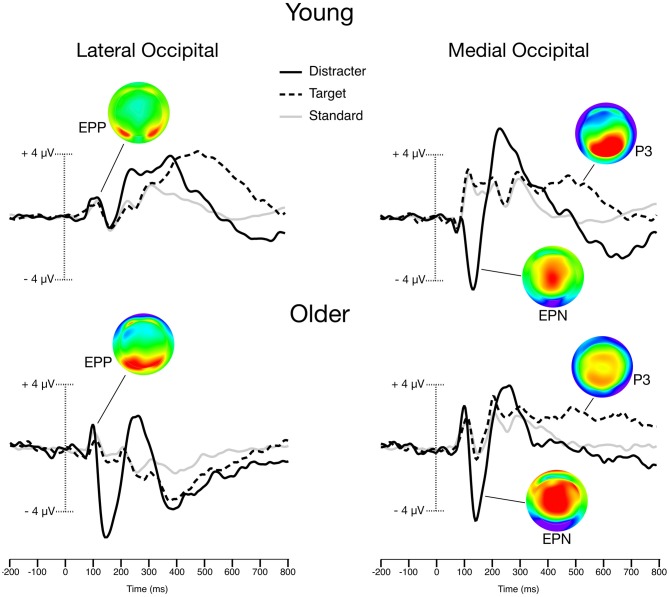
Grand-averaged Event-related potentials (ERPs) from the color distracter block trials. Scalp maps illustrate the peak amplitudes of color distracter processing for early posterior positivity (EPP; 100 ms), Early Posterior Negativity (EPN; 140 ms), and P3 (400 ms). Lateral occipital waveforms were averaged from O1, O2, PO7, and PO8 electrodes. Medial occipital waveforms were averaged from O1, O2, and Oz electrodes.